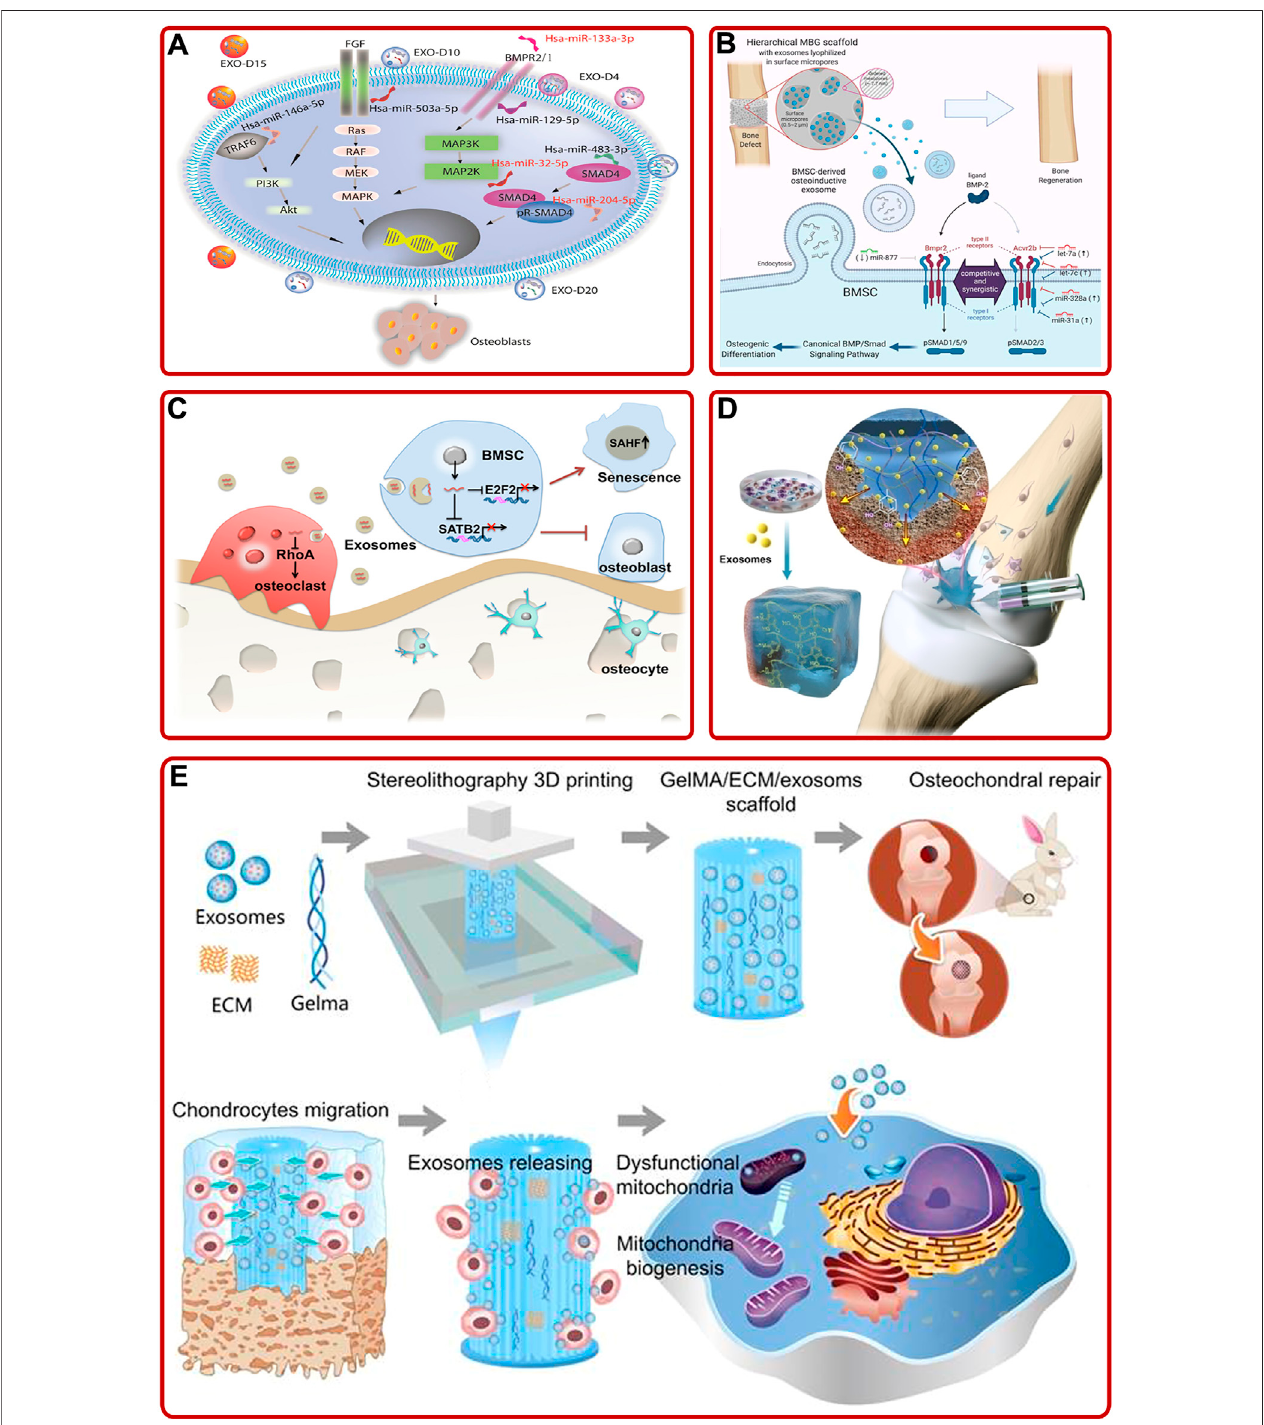
FIGURE 2 | (A) BMSC-derived exosomes induced osteogenic differentiation of hMSCs through mediating the PI3K/Akt and MAPK signaling pathways by upregulating/downregulating osteogenic and anti-osteogenic miRNAs (Zhai et al., 2020). (B) Schematic of the mechanism BMSC-derived osteoinductive exosomes functionalizedhierarchical MBGscaffoldpromotedboneregeneration(LiuA.etal.,2021). (C) AgedBMSC- derivedexosomalmiR-31a-5p inhibited BMSCsfunctionsin cellular aging and osteogenesis via the E2F2 and SATB2 signaling pathways and promoted osteoclastic differentiation via the RhoA signaling pathway (Xu et al., 2018). (D) Schematicdescribedthatsuper fi cialcartilagecould beregeneratedbyinjectingBMSC-derived exosomes containinghydrogels (ZhangF.-X.etal.,2021). (E) 3D printed ECM/Gelma/BMSC-derived exosomes scaffold enhanced chondrocyte mitochondrial biogenesis and promoted osteochondral regeneration in rabbit models (Chen et al.,